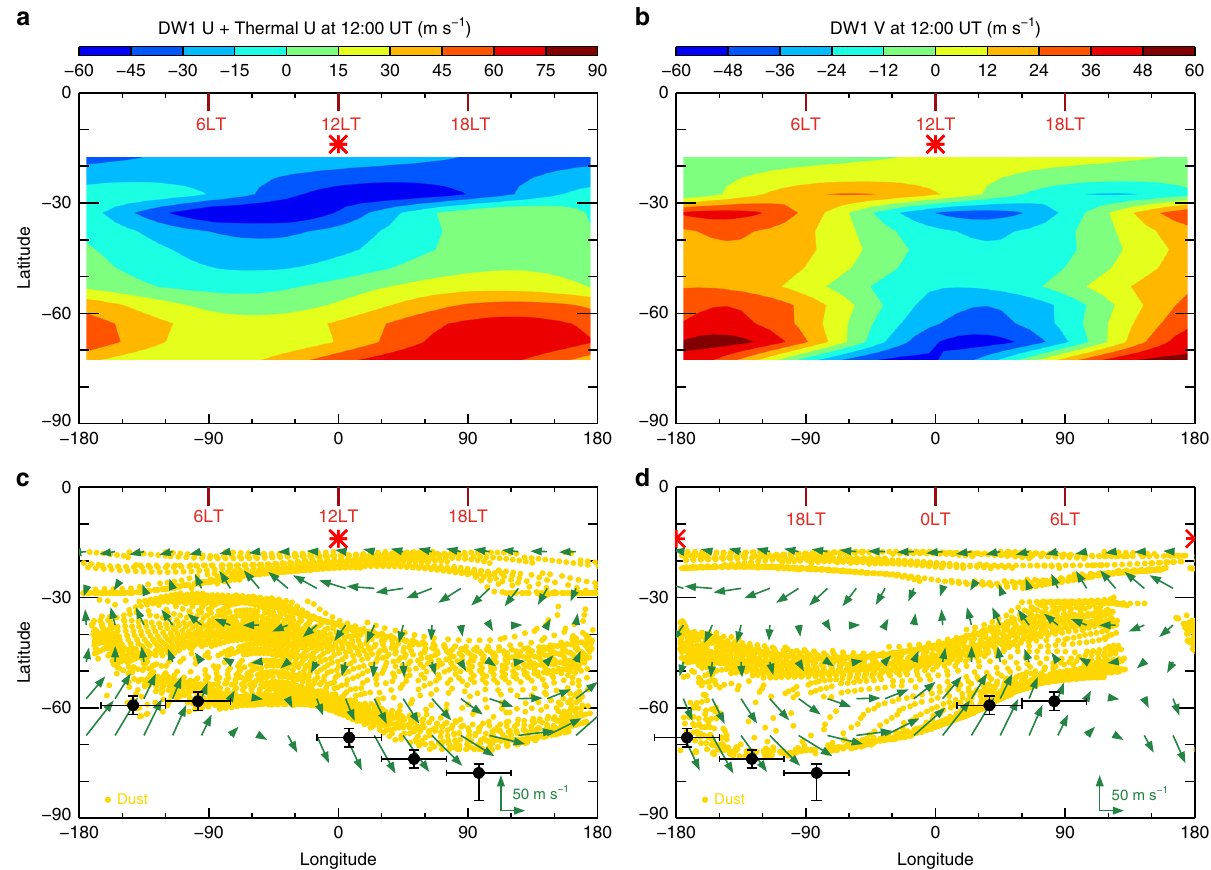
Fig. 4 Diurnal variation of the dust distribution in the horizontal plane simulated using the Lagrangian particle analysis. The reconstructed zonal ( a ) and meridional ( b ) winds are derived from zonal gradient wind plus DW1 winds and averaged between 20 and 70 Pa at 12:00 universal time (UT), L s = 220 – 221.9°. The phases of U and V of the DW1 winds are consistent with those shown in Supplementary Fig. 8. The virtual dust particle distributions (yellow points) over-plotted with the horizontal wind vectors (arrows) at 12:00 UT and 24:00 (00:00) UT, shown in c , d , respectively, are extracted from the Lagrangian particle analysis. The black dots with error bars in ( c , d ) show the latitude values of the observational dust front (see Supplementary Fig. 6) at corresponding local times. The red ticks indicate the local times (LT). From c , d , the sun (red star symbols) propagates westward from 0° to 180° longitude, along with the wind fi eld pattern and the wave-like dust